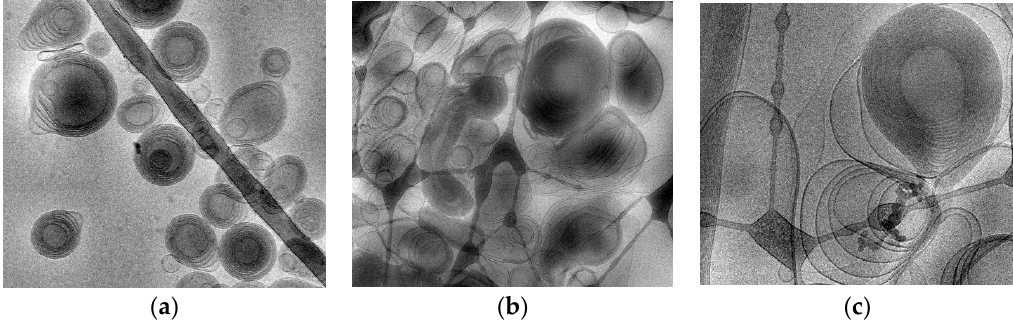
Figure 2. Cryo-transmission electron microscopy images (Cryo-TEM) of CA-ETHO ( a ) and CA- ETHO-pol ( b , c ). Bar corresponds to 200 nm ( a , b ) or 100 nm ( c ).